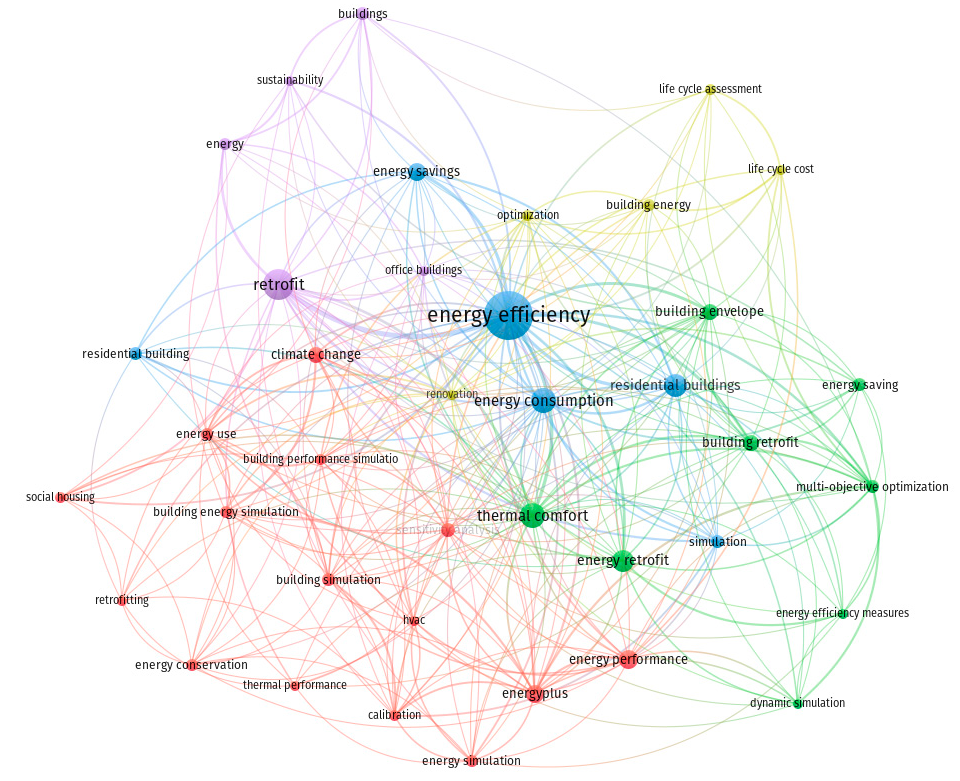
Figure 6. Areas covered by the articles related to building envelope energy retrofit.